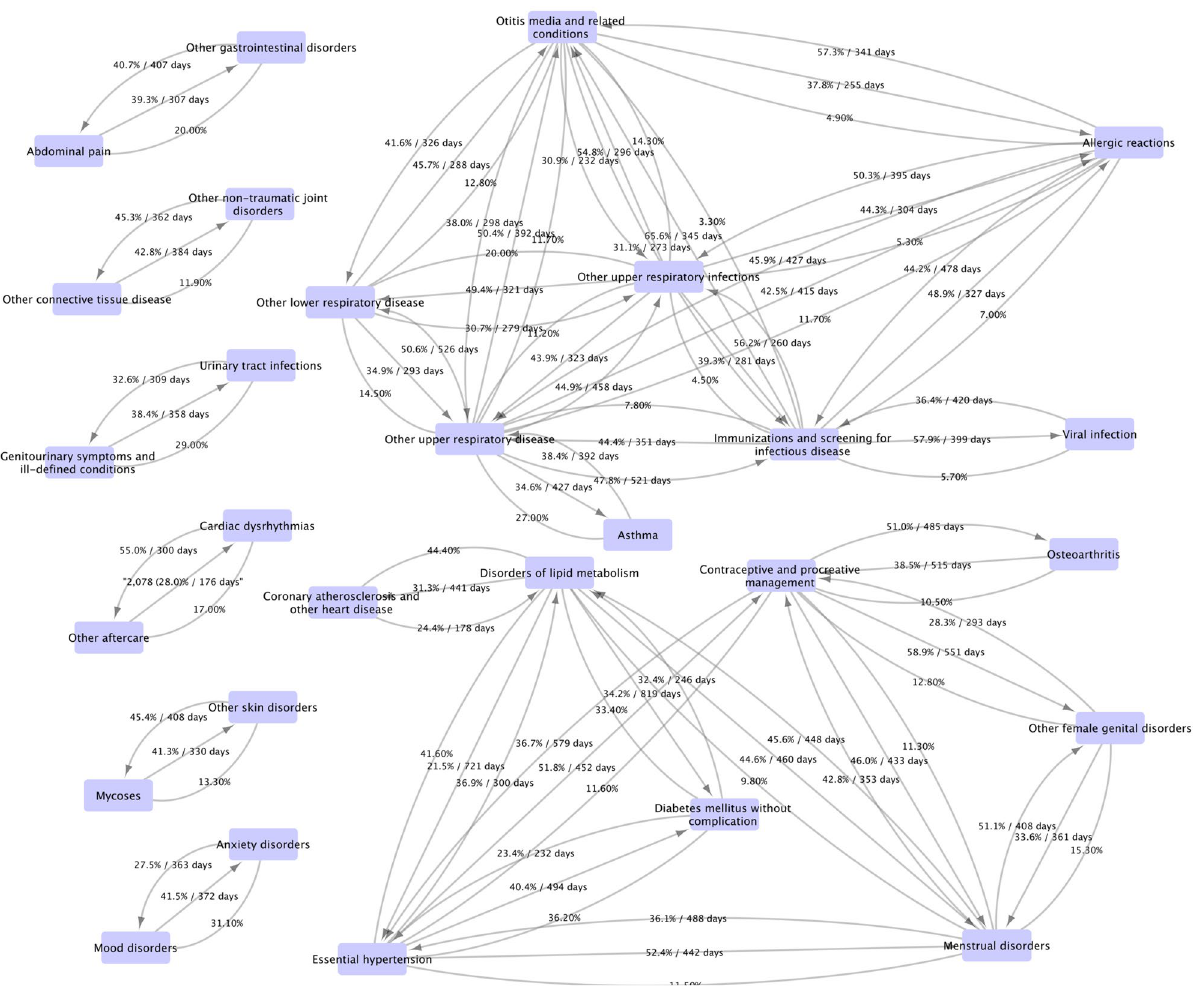
Figure 4. Characteristics of disease pairs using network graphs with strong correlations: percentages and median days of early occurrence. The arrow direction indicates the disease occurrence time order. No arrow means two diseases diagnosed at the same date. The figure was generated by using Cytoscape (version 3.7.1) software (https:// cytos cape.